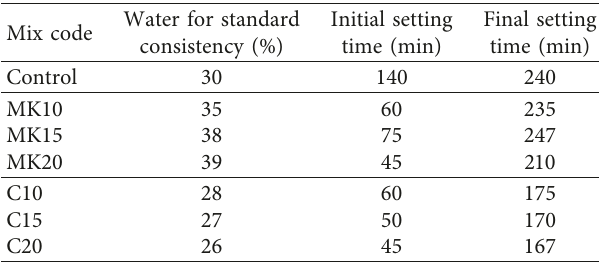
Table 5: Standard consistency water and setting times of binder paste.